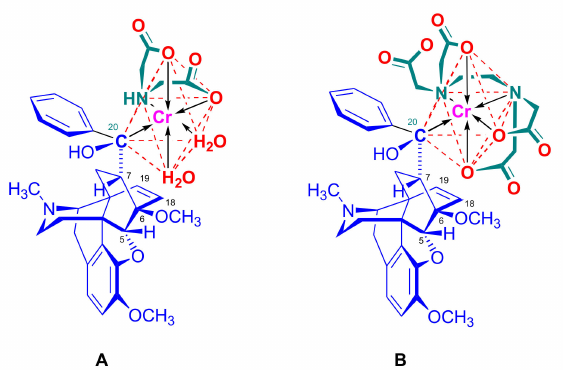
Figure 99. Structures of proposed organometallic complex intermediates formed from nepenthone in aqueous medium. A : [Cr(IDA)(H 2 O) 3 ]-nepenthone complex. B : [Cr(EDTA)] 2 − -nepenthone